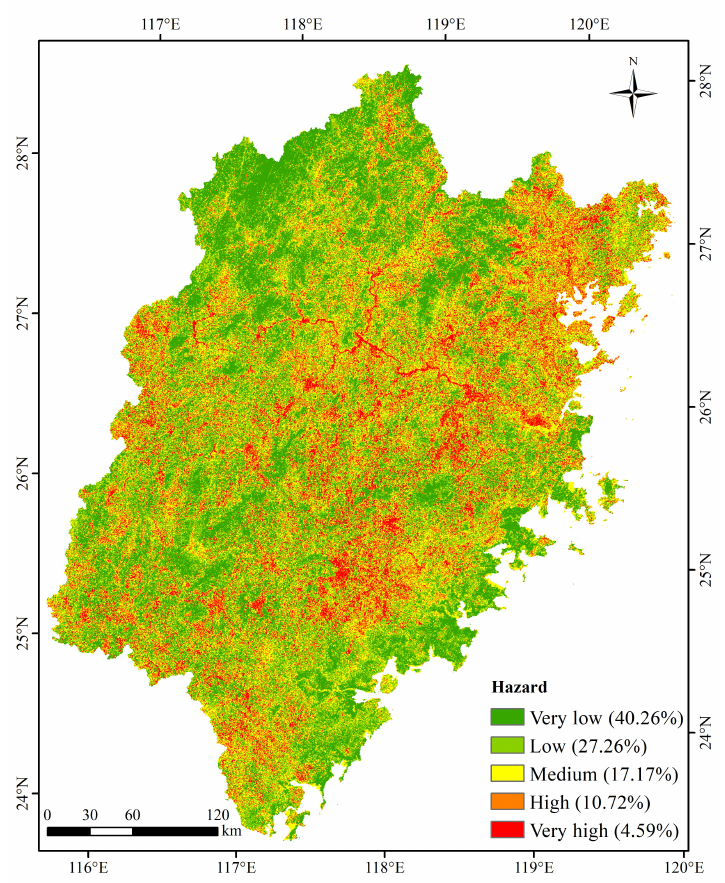
Figure 6. Spatial distribution of hazard of geological